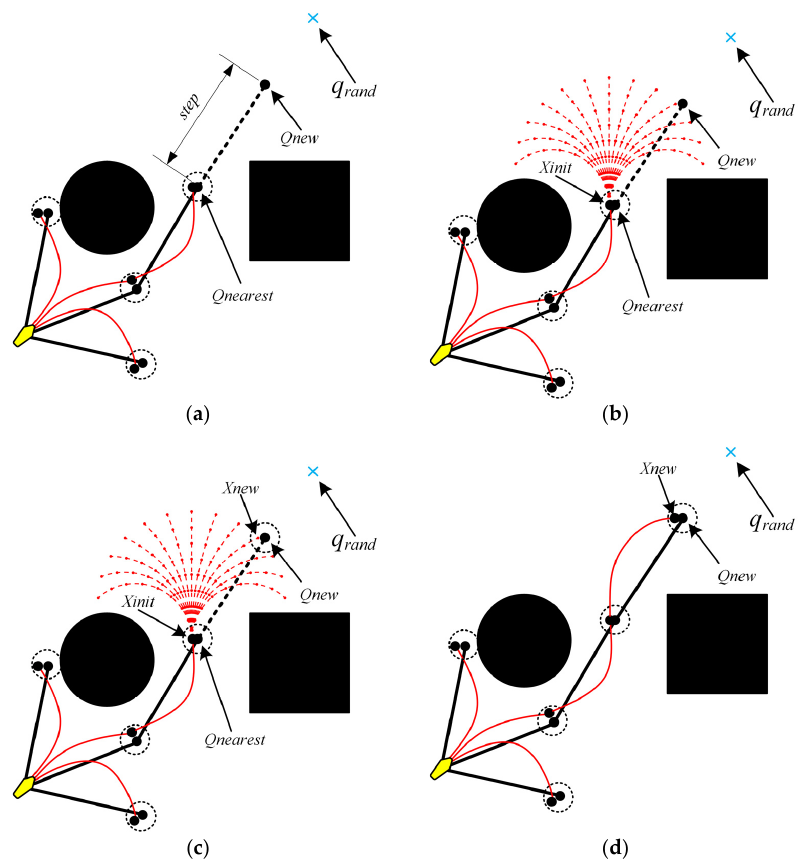
Figure 3. Extension rules based on state prediction: ( a ) extending Q new node; ( b ) predicting states; ( c ) determining validity; ( d ) extending node. Algorithm 1, Line 4 detects whether the proposed extended node collides with